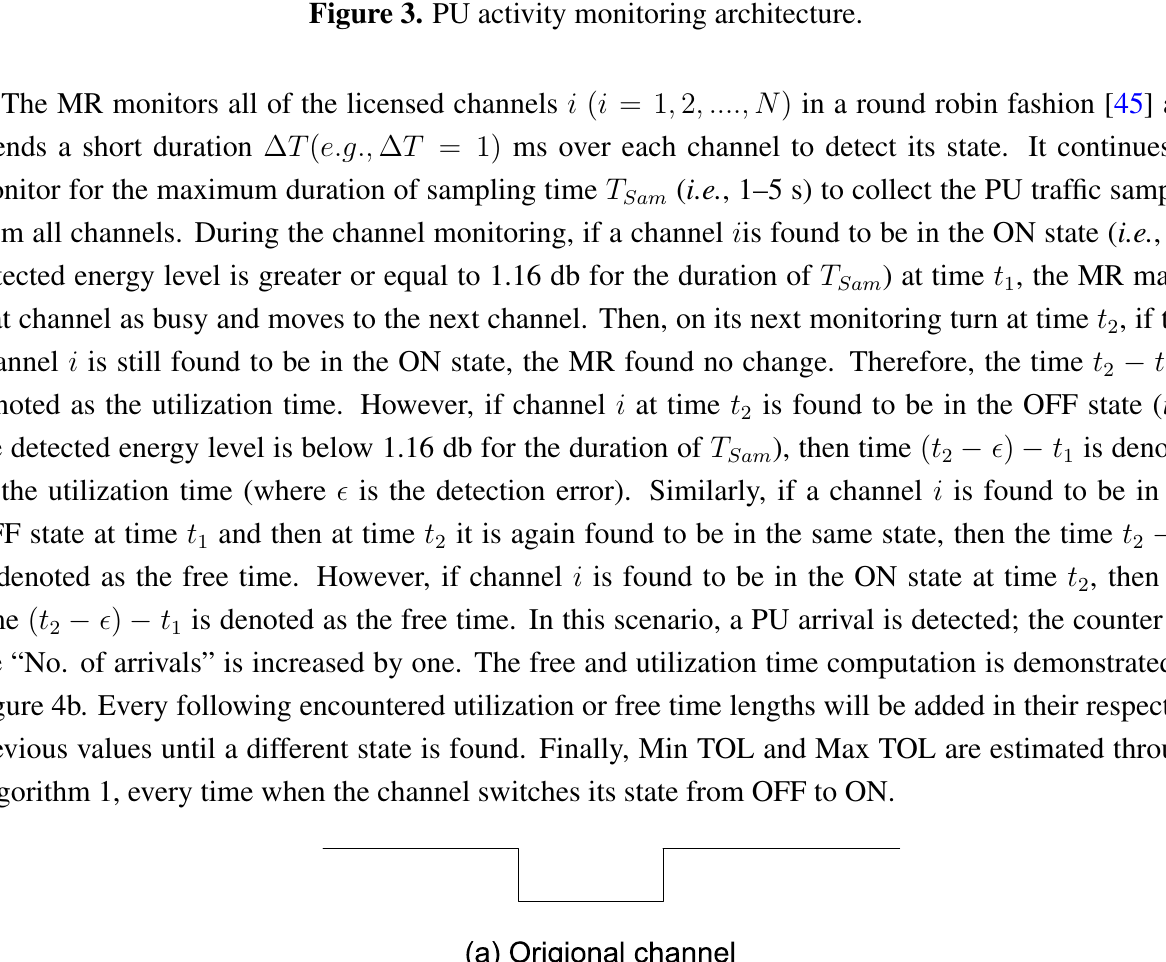
Figure 3. PU activity monitoring architecture.